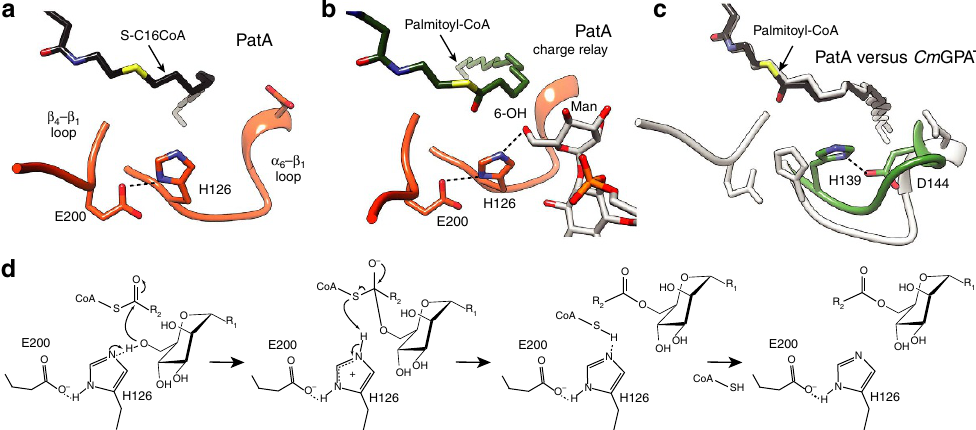
Figure 8 | Catalytic mechanism of PatA. ( a ) Active site configuration of PatA, as visualized in the crystal structure in complex with S-C16CoA. (PatA–S-C16CoA) ( b ) Active site configuration of PatA as visualized in the docking of palmitoyl–CoA and PIM 2 (the atomic coordinates of palmitoyl–CoA were derived from S-C16CoA following in silico addition of an oxygen atom at postion C16 of S-C16CoA). The charged relay system formed between E200, H126 and the 6-OH of the mannose linked to the 2-position of inositol (ino) is highlighted. ( c ) Structural superposition of the catalytic site of PatA (grey) and Cm GPAT (green) with palmityol–CoA docked into Cm GPAT. ( d ) Proposed catalytic mechanism for PatA.